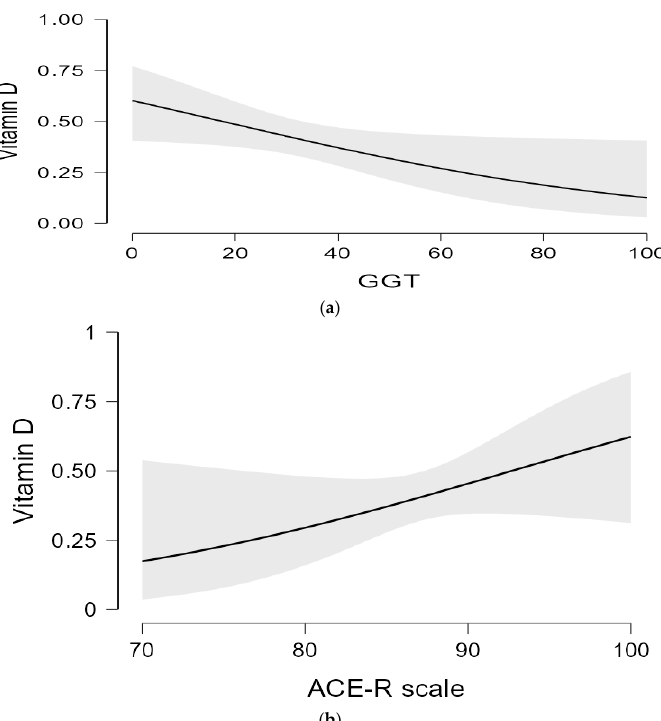
Figure 3. ( a ) Regression analysis of gamma glutamyltransferase. Note : GGT—gamma glutamyltransferase ( b ) Regression analysis of ACE-R scale. Note: ACE-R Total—Addenbrooke’s Cognitive Examination—Revised total score.